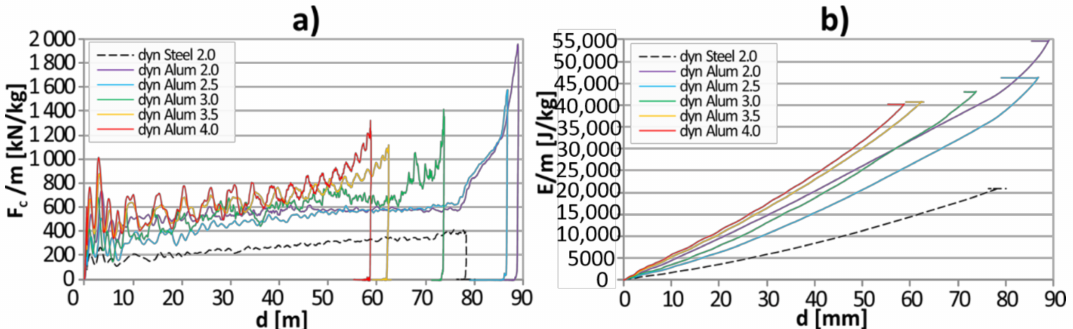
Figure 8. The results of dynamic compression tests: ( a ) E / m = f(d); ( b ) F C / m =